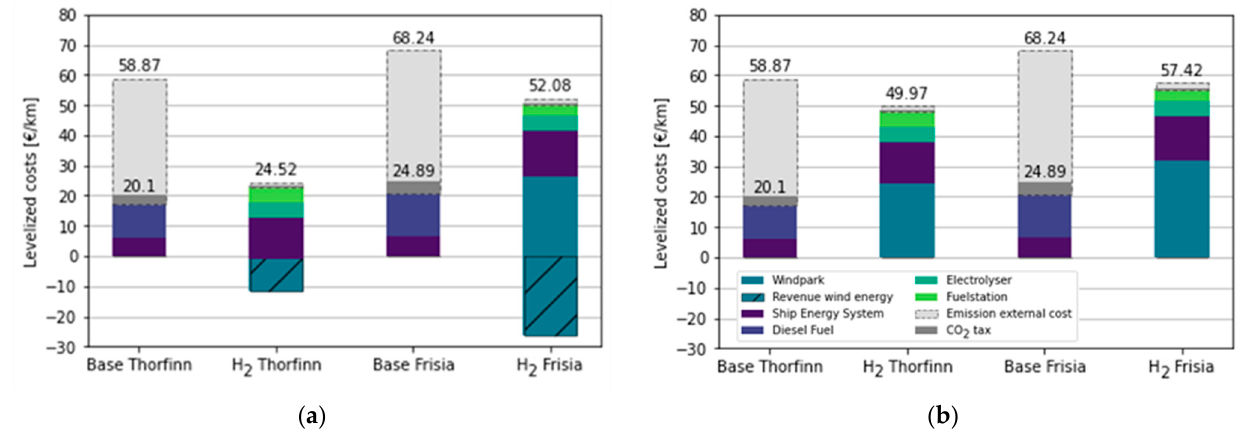
Figure 7. LCOT of a hydrogen fuel system, ( a ) including wind farm, electrolysis, storage, fueling system and fuel cell propulsion system, ( b ) without wind farm and using grid electricity for hydrogen production at 10 ct/kWh (Source: By author).